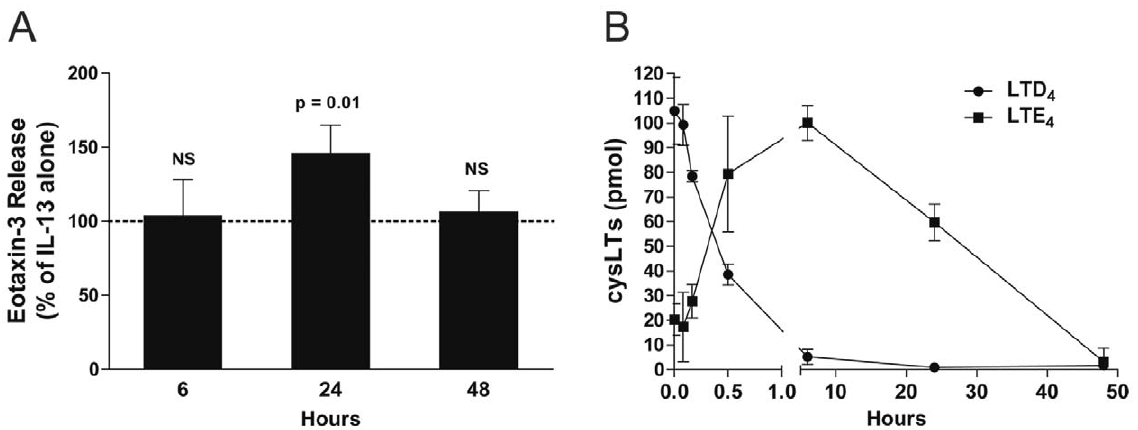
Figure 3. Effect of LTD 4 on the IL-13-induced release of eotaxin-3 by airway epithelial cells. A ) Airway epithelial cells were incubated with 10 ng/ml IL-13 alone or in combination with 100 nM LTD 4 for up to 48 hours. Incubations were stopped by removing the supernatants and eotaxin-3 was quantified as described in Material and Methods . Data are expressed as % of IL-13-treated cells for each incubation period. The data represent the mean ( 6 SEM) of four independent experiments. NS=not significant. B ) Airway epithelial cells were incubated with 50 ng LTD 4 for up to 48 hours. Incubations were stopped by adding one volume of cold incubation buffer. Samples were harvested then processed for the analysis of LTD 4 and LTE 4 by reverse-phase HPLC as described in Material and Methods . Data are the mean ( 6 SEM) of three independent experiments, each performed in duplicate.